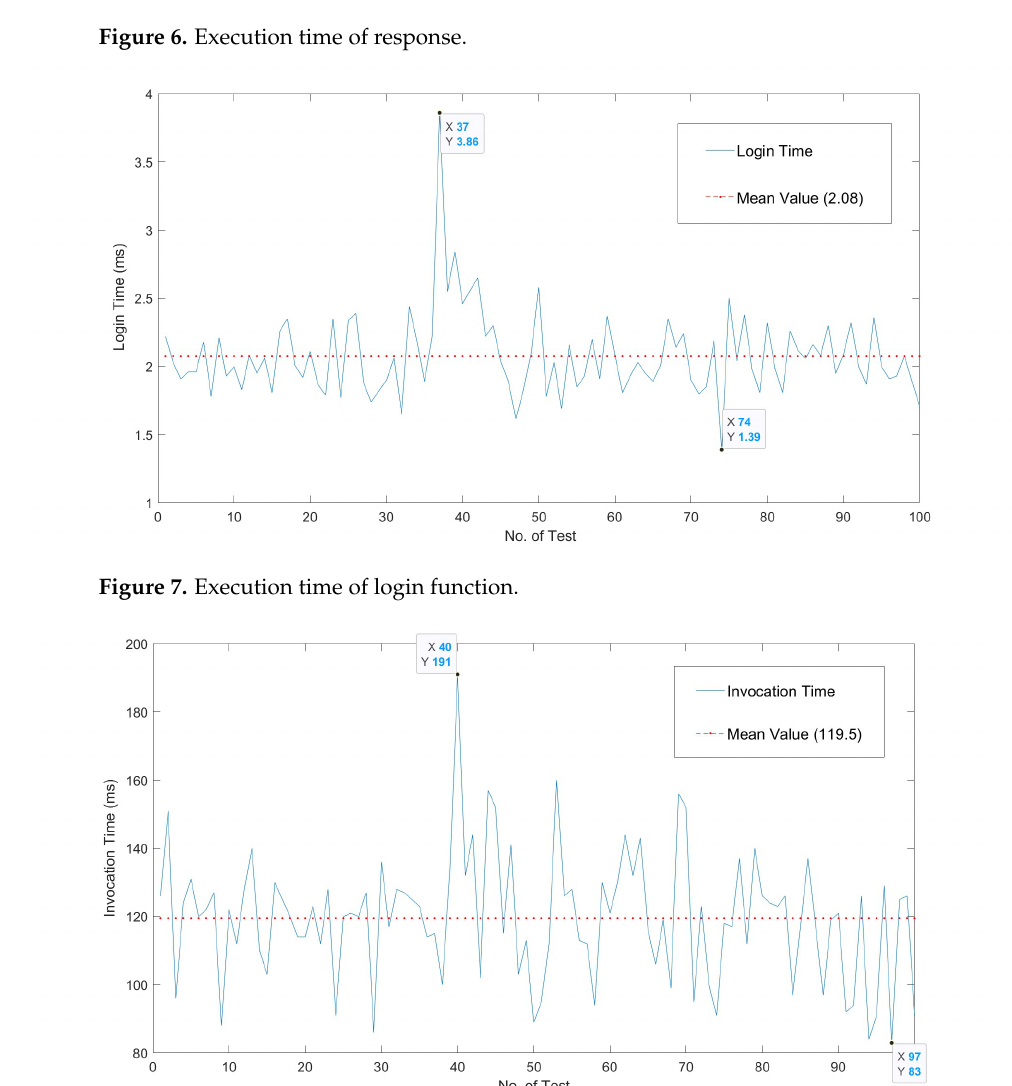
Figure 8. Interaction